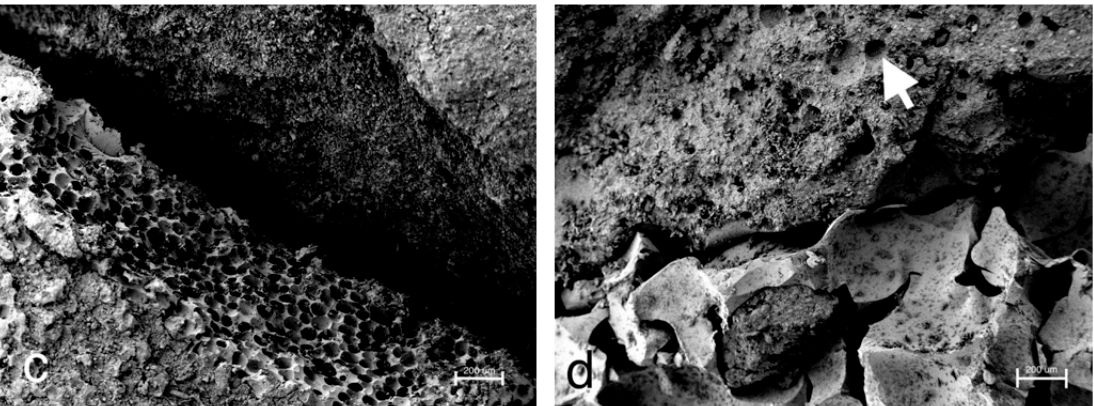
Figure 11. SEM images of the cement–bone interface. Smooth interdigitation of the MPC and confirmation of stereomicroscopic findings: As already revealed on the stereomicroscopic images, the MPC demonstrated a seamless filling of the adjacent spongiosa cavities at the cement–bone junction (arrowhead in ( a )). For the drillable CPC stored under humid conditions, in contrast to the stereomicroscopic images, a gap to the adjacent spongiosa became visible ( b ). However, a filling of nearby spongiosa cavities could be detected as well (arrowhead in ( b )). During the preparation process for SEM, the humid cement was dried necessarily in a desiccator. Congruently, the SEM images for the drillable CPC stored under dry conditions revealed a gap ( c ). Graftys ® Quickset demonstrated a close connection to the adjacent spongiosa ( d ). Moreover, the macroporous and mesoporous structures of the bone substitute can be visualized (arrowhead in ( d )).